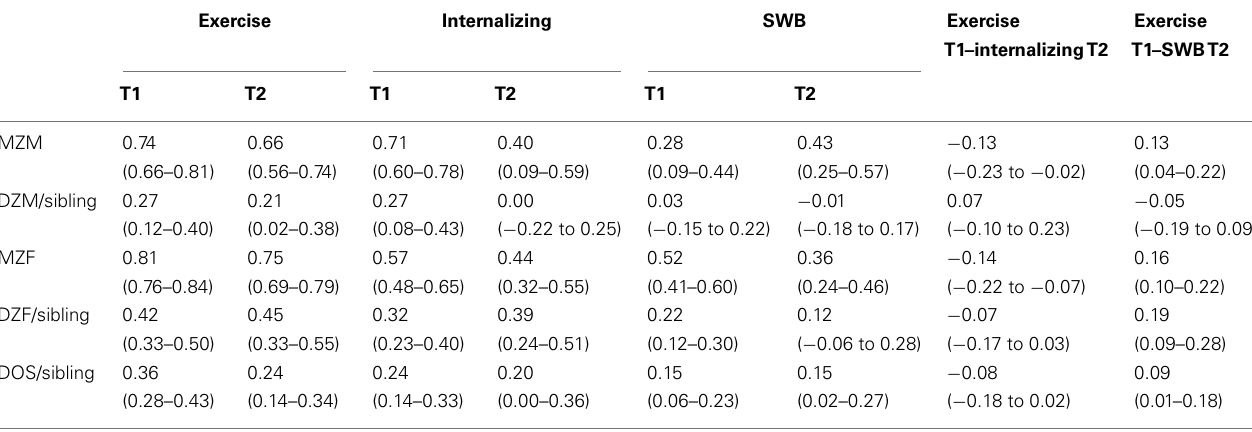
Table 4 |Twin and twin-sibling correlations for exercise behavior, internalizing problems and SWB at the first (T1) and second (T2) measurement occasion, and the longitudinal cross-twin cross-trait and cross-sibling cross-trait correlations for exercise behavior, internalizing problems and subjective wellbeing.